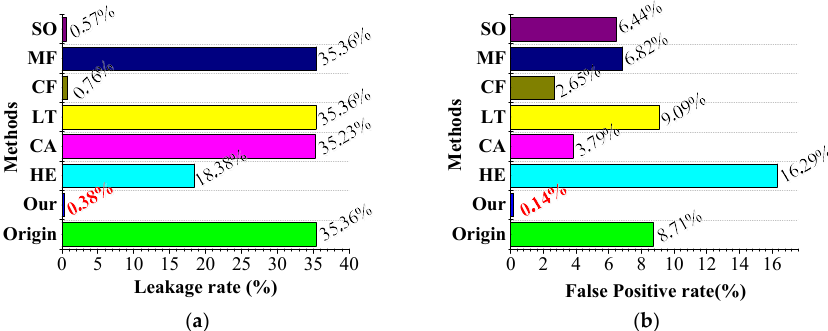
Figure 19. Leakage and false-positive rates of different methods in an outdoor complex environment. ( a ) Leakage rates. ( b ) False-positive rates.